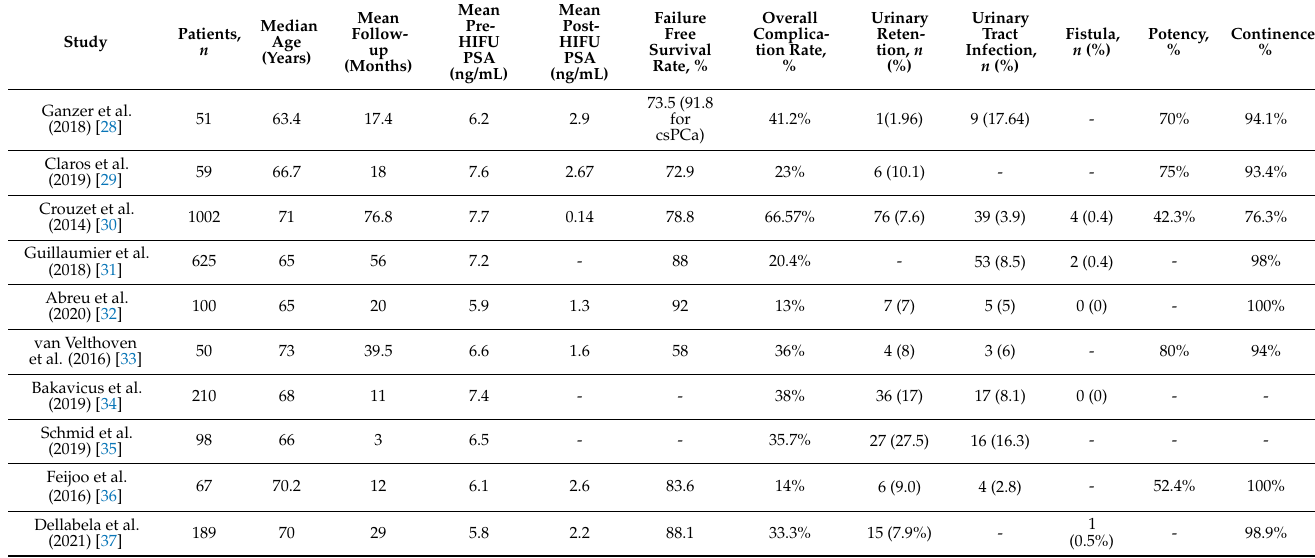
Table 1. Oncological and operative outcomes of HIFU focal therapy for the treatment of prostate